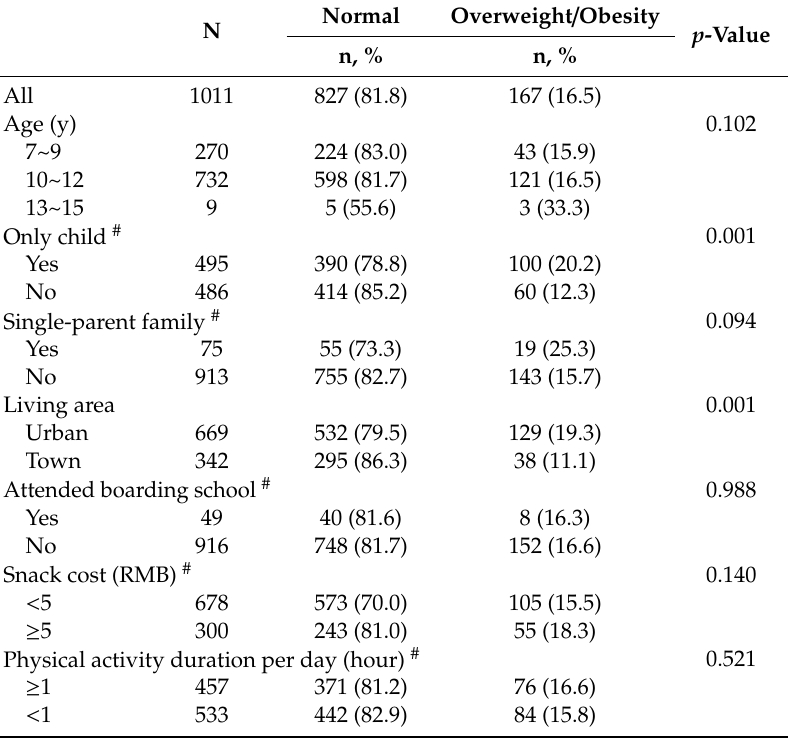
Table 2. Sociodemographic information of female school-age children by weight status. Normal Overweight / N